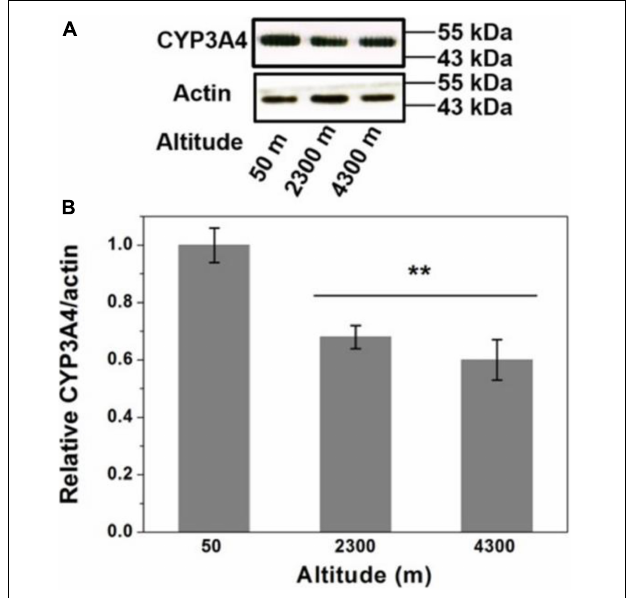
Figure 5 | Western blots analysis of protein expression of CYP3A4 in the liver. (A) Downregulation of protein expression of CYP3A4 in high altitude. Actin was used as a loading control. (B) The quantification of the blots. The data are expressed as the means ± SE of three experiments. ** P < 0.01 versus the low altitude group (50